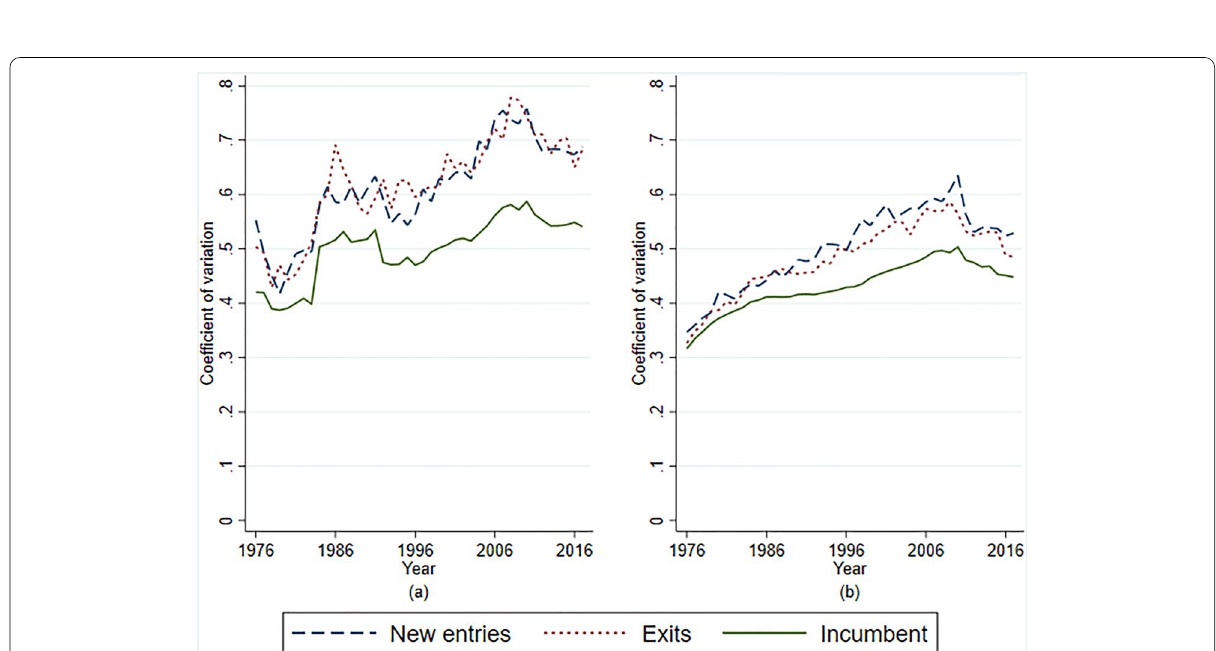
Fig. 12 Coefficient of variation of average real wages by skill group. Average real wages of high-skilled employees are depicted in ( a ) and average real wages of low-skilled employees are depicted in ( b